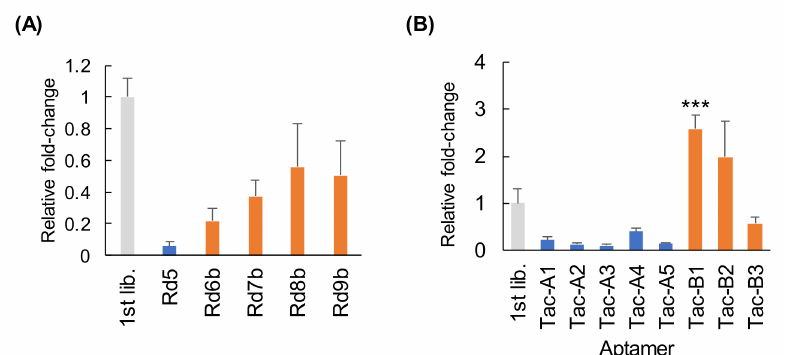
Figure 4. Evaluation of the degree of internalization of anti-TROP2 artificial nucleic acid aptamers by MCF-7 cells. ( A ) Evaluation of the internalization of each library obtained via CE-SELEX and cell-SELEX using MCF-7 cells. Each library was incubated with MCF-7 cells, washed, and treated with DNase I. Internalized species were quantified with qPCR. The degree of internalization was graphed as a ratio to that of the initial library (1st lib.). ( B ) Evaluation of the internalization of each aptamer obtained via CE-SELEX and hybrid-type SELEX. The evaluation was performed with qPCR using the same protocol as that used for libraries. These data represent the mean ± SD values of three independent experiments. Rd = Round. *** p < 0.001; two-sided Student’s t -test, compared to values for the 1st